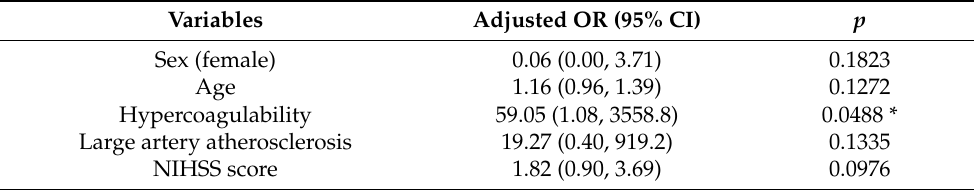
Table 4. Multivariate logistic regression model of independent predictors of a large size of acute ischemic focus (>2 cm 3 ).